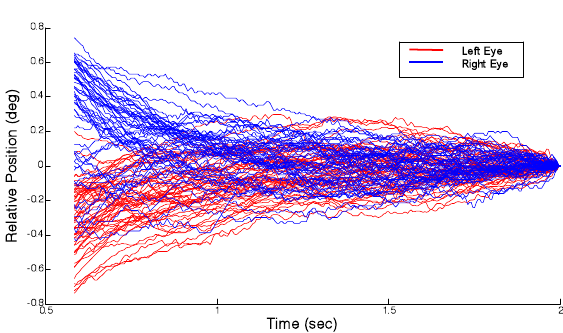
Figure 2 The fusion sustaining portion of 42 responses to a step change in pure vergence plotted as left (red) and right (blue) eye movements. The movements are small (less that 1.0 deg) and usually asymmetrical; that is, one eye moves more than the other.